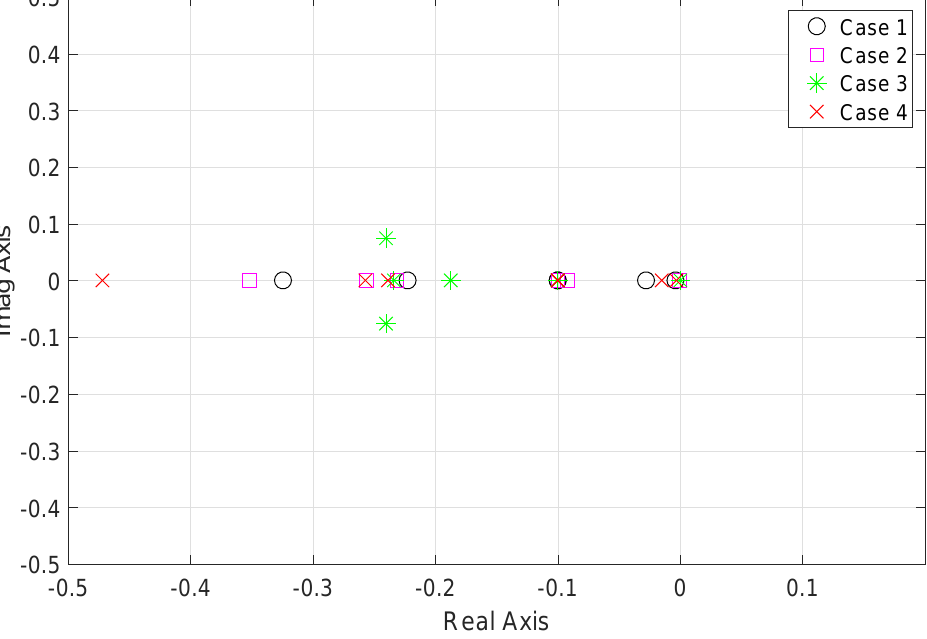
Figure 6. Eigenvalues obtained from the normal case